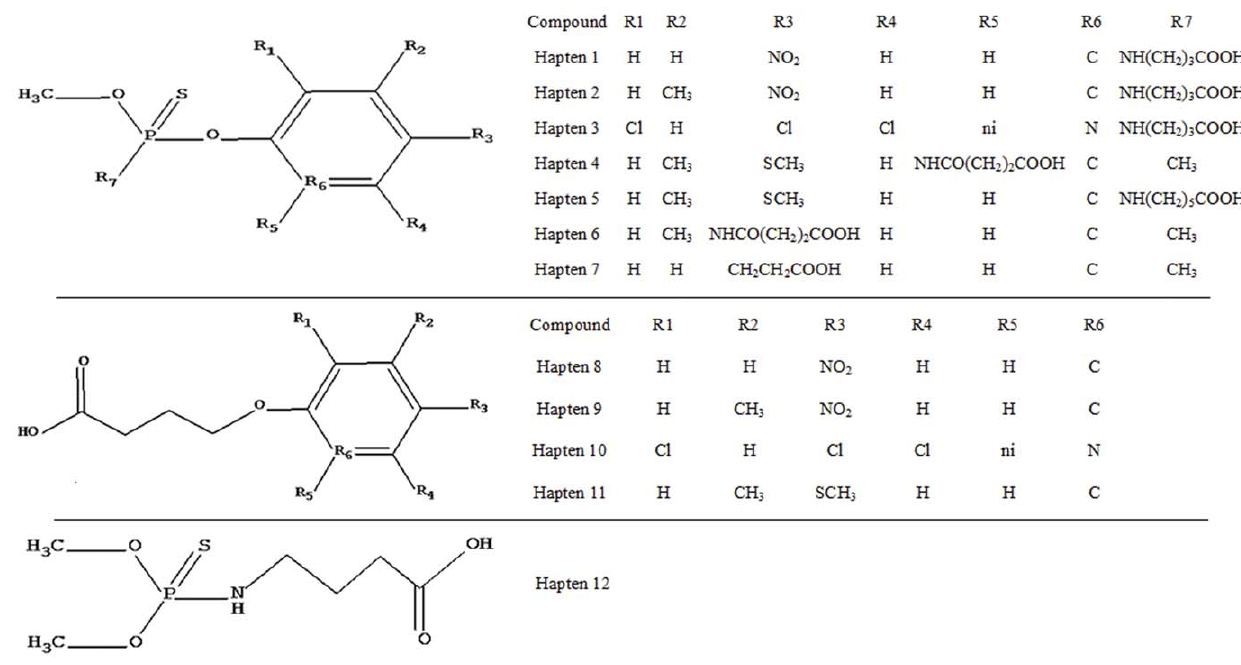
Figure 1. Molecular structures of the haptens. Hapten 1 was used as immunizing hapten and homologous coating hapten, hapten 2 to 12 were used as heterogenous coating hapten candidate. ni: no atom.